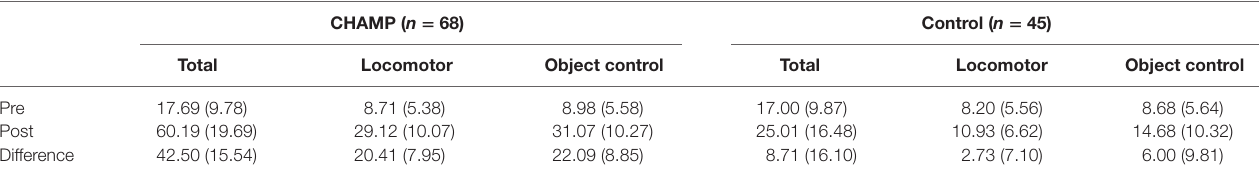
TaBle 2 | Full descriptive statistics for motor